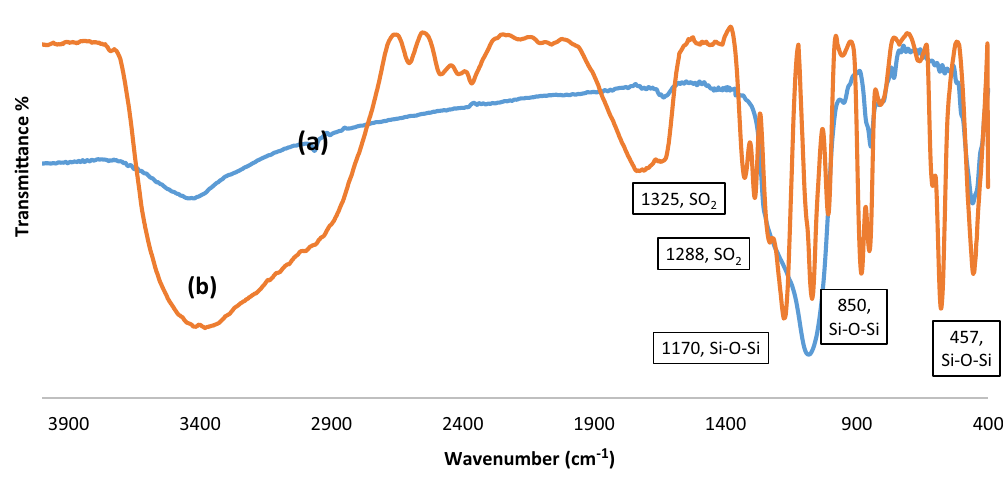
Figure 2. FT-IR spectra of nano-ordered MCM-41 ( a ), and MCM-41-SO 3 H ( b